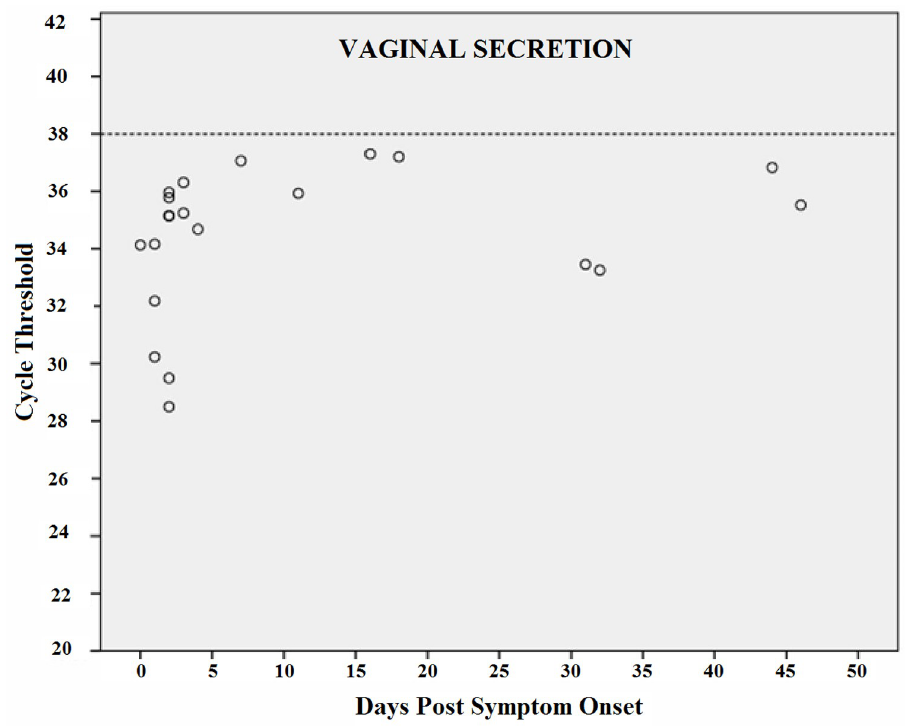
Fig 9. CHIKV Cycle Threshold (Ct) by days after the onset of symptoms in Vaginal Secretion.